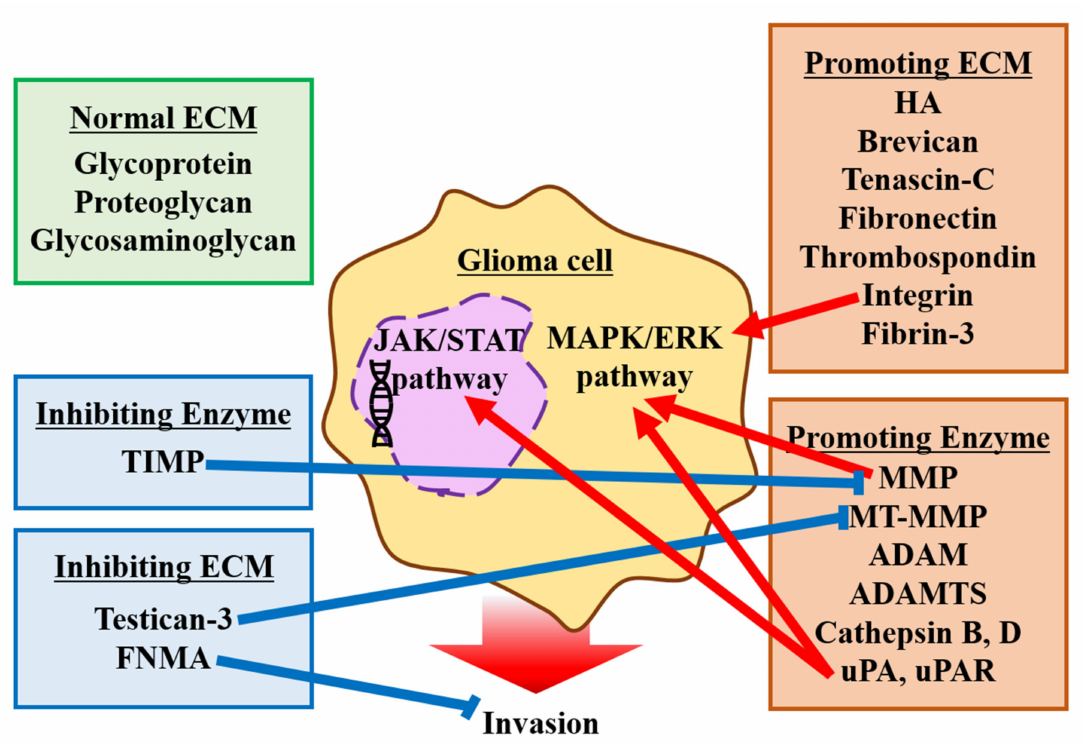
Figure 2. Schematic of the factors affecting the alteration of the glioma microenvironment by extracel- lular matrices (ECMs) and enzymes. Basically, there are some types of ECM that are independent of glioma cell invasions. However, the alteration of the microenvironment surrounding gliomas is affected by ECMs and enzymes, which almost promote the invasiveness of glioma cells. There are mainly two signaling pathways subserving glioma cell invasion: the Janus kinase (JAK)/signal transducer and activator of transcription (STAT) pathway, and the mitogen-activated protein kinase (MAPK)/extracellular signal-regulated kinase (ERK) pathway. Red arrows indicate the activation of signaling, while blue arrows indicate the inhibition of signaling. Abbreviation: ADAM; a disinte- grin and metalloproteinase, ADAMTS; ADAM with thrombospondin domain, FNMA; fibronectin matrix assembly, HA; hyaluronic acid, MMP; matrix metalloproteinase, MT-MMP; membrane-type MMP, TIMP; tissue inhibitor of metalloproteinase, uPA; urokinase-type plasminogen activator, uPAR; uPA